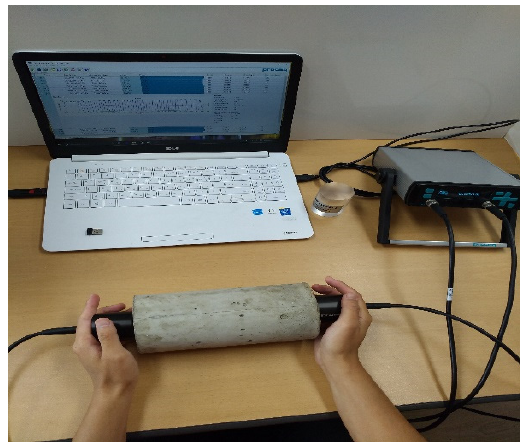
Figure 3. Direct measurement of UPV test.